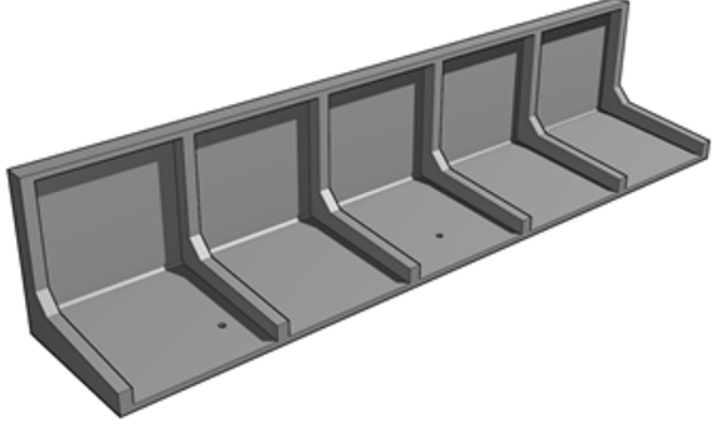
Figure 1. Special shaped parapet block